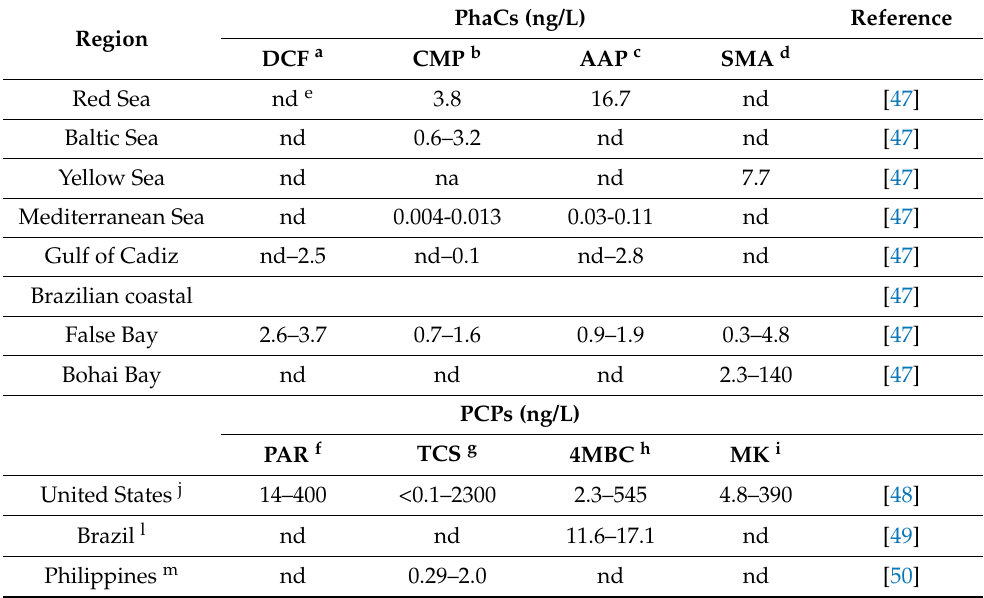
Table 2. Levels of PhaCs and PCPs in marine